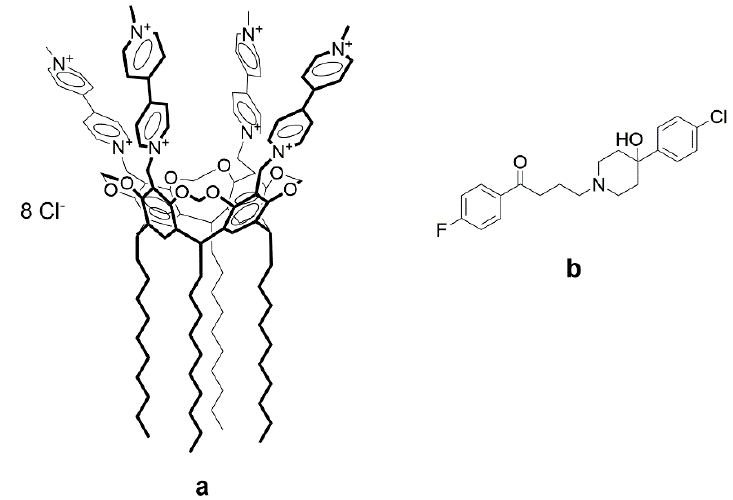
Figure 1. Molecular structures of calix[4]resorcinol VC10 ( a ) and Hal ( b ).